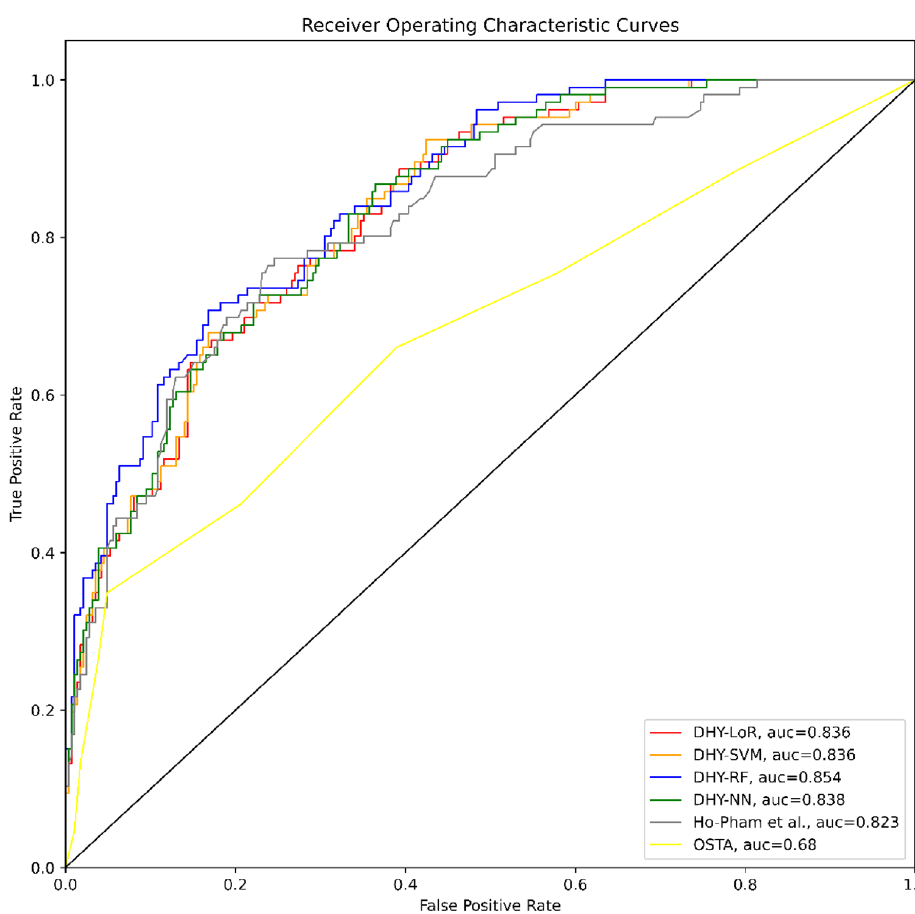
Figure 3. The ROC curves in the second scenario.